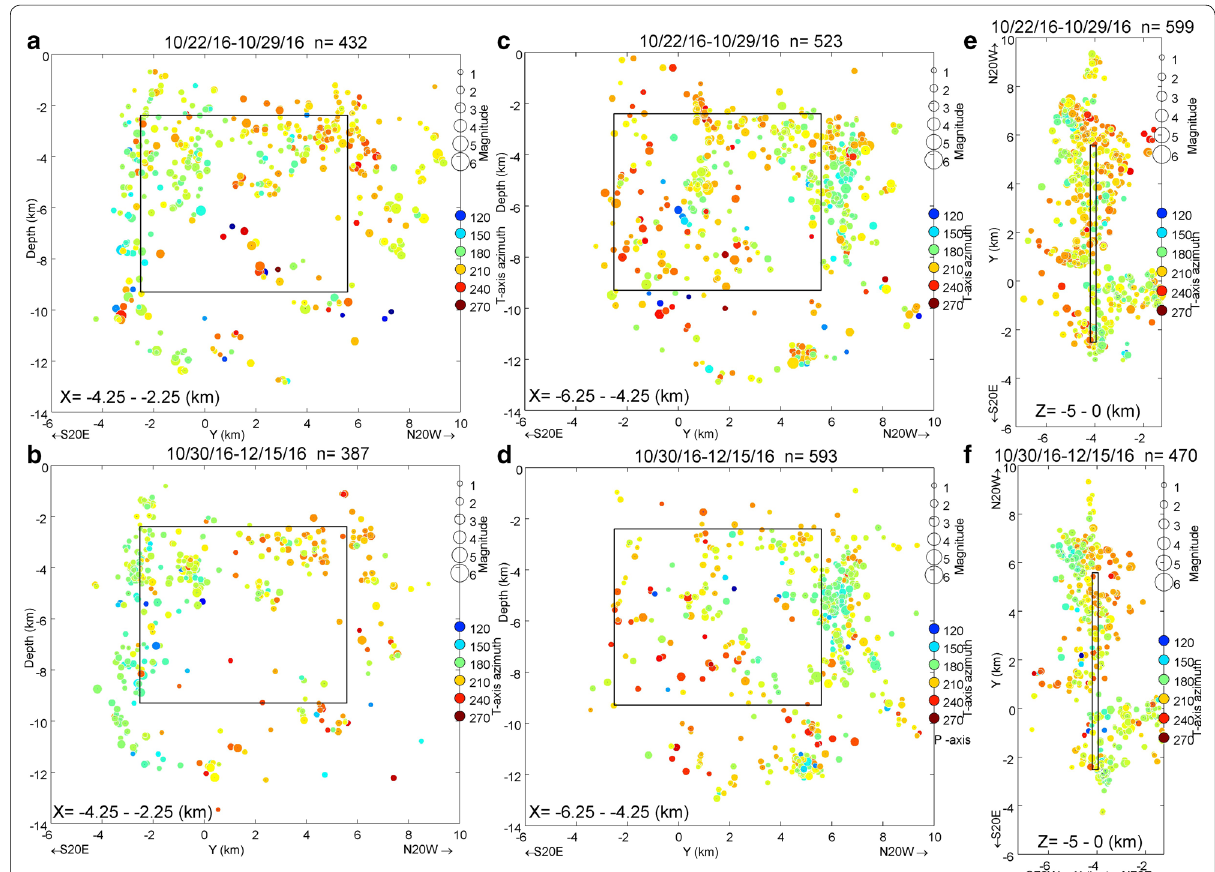
Fig. 3 Temporal changes in T-axis azimuths. a T-axis azimuths projected on the vertical cross section along the fault for October 22–29 in the eastern side of the fault. b Those for aftershocks from October 30–December 15 in the eastern side of the fault. c Those for aftershocks in the former period in the western side of the fault. d Those for aftershocks in the latter period in the western side of the fault. e Those projected on the horizontal plane for aftershocks in the former period at depths of 0–5 km. f Those for aftershocks in the latter period at depths of 0–5 km. T-axis azimuths from 90° (East) through 180° (South) to 270° (West) are represented by solid colors that change from dark blue to green to brown. Rectangles show the mainshock fault estimated from InSAR and GNSS data assuming uniform slip (GSI